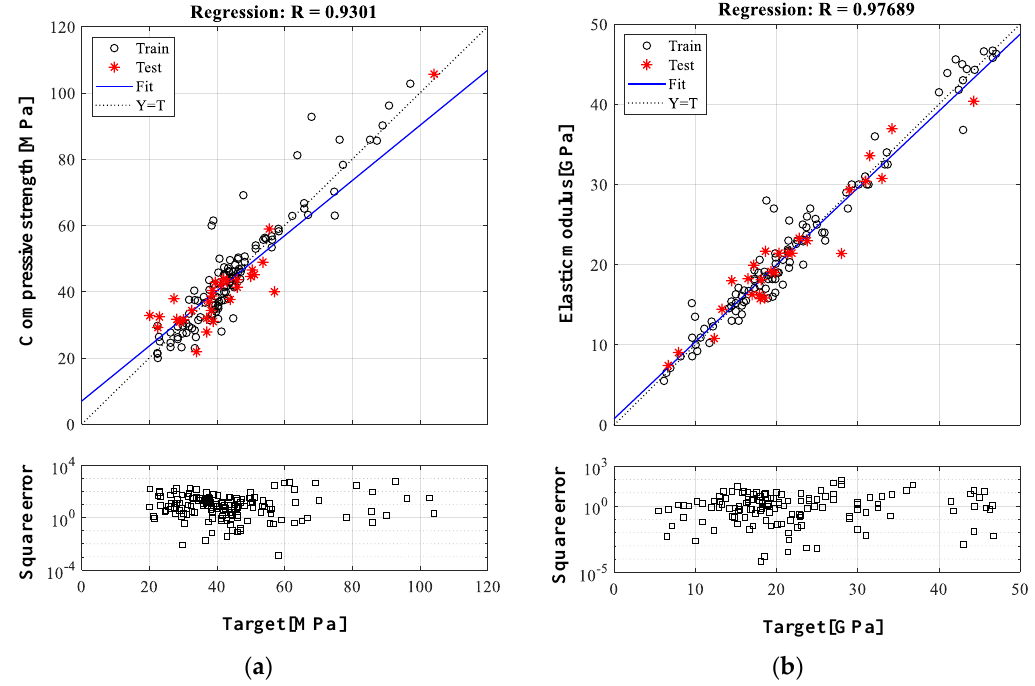
Figure 4. Prediction results from ANN model: ( a ) compressive strength and ( b ) elastic modulus.